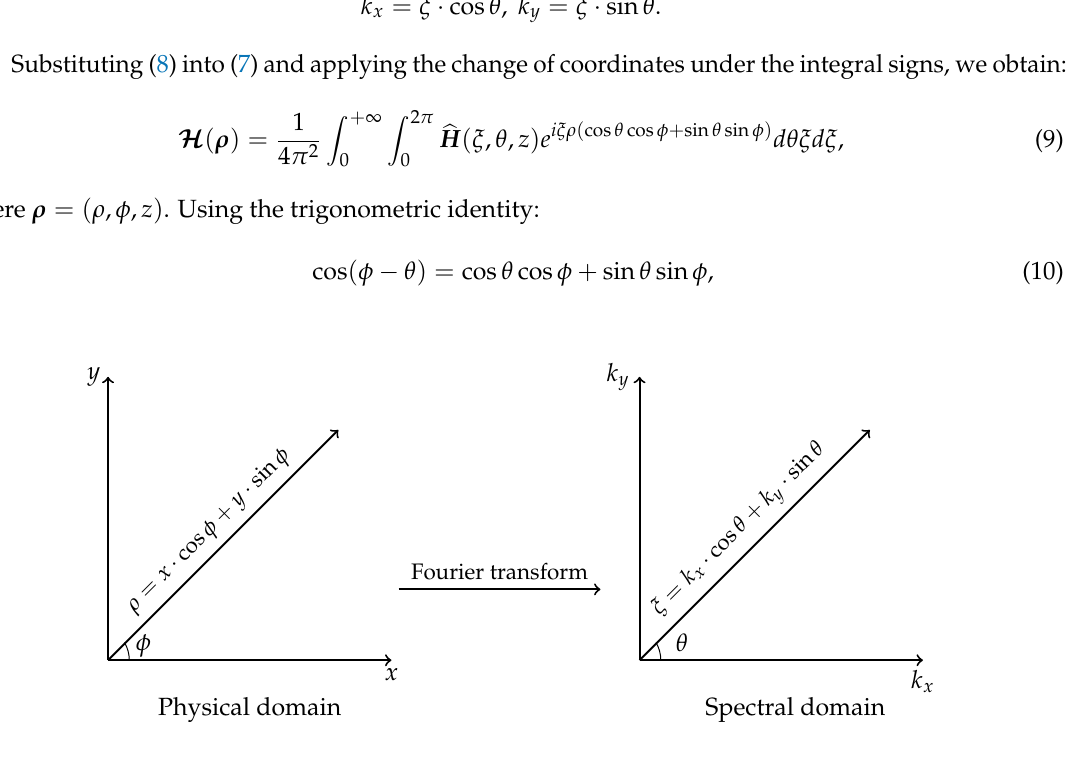
Figure 1. Cartesian and cylindrical systems of